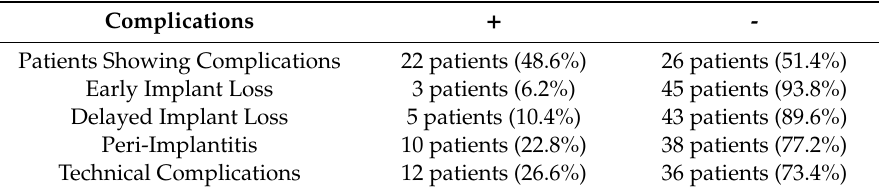
Table 4. Percentage of patients who showed complications during the 17 years follow-up. Complications + -